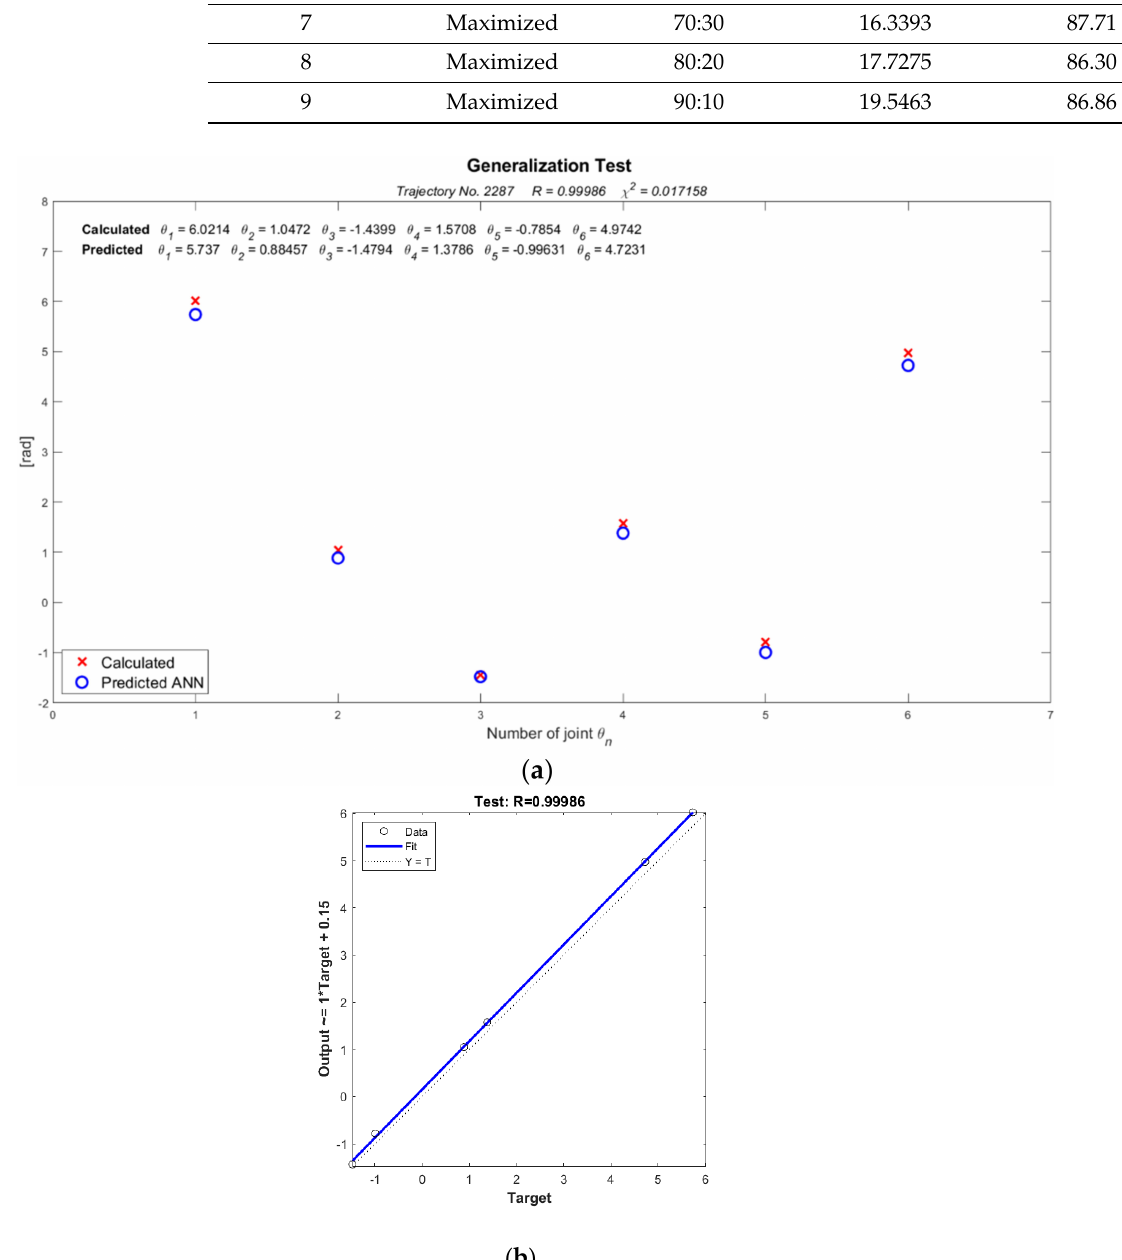
Figure 8. Trajectory of the manipulator with the best prediction and correlation test: (a) best pre- dicted values; (b) correlation test.